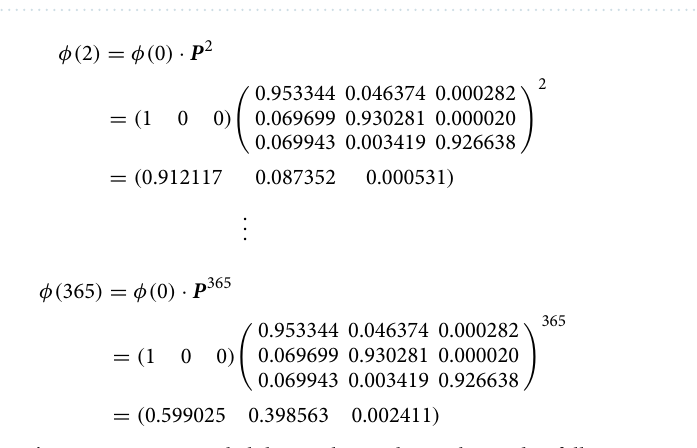
Figure 6. Comparison of statistical and analytical values. ( a ) Probability of being at normal, ( b ) Probability of being at risk, ( c ) Probability of being at